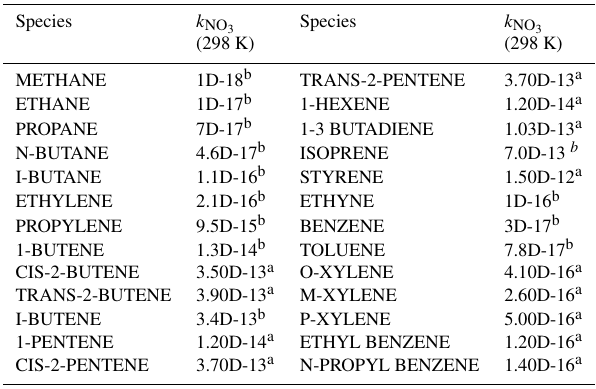
Table A1. VOCs used to calculate NO 3 reactivity ( k NO model